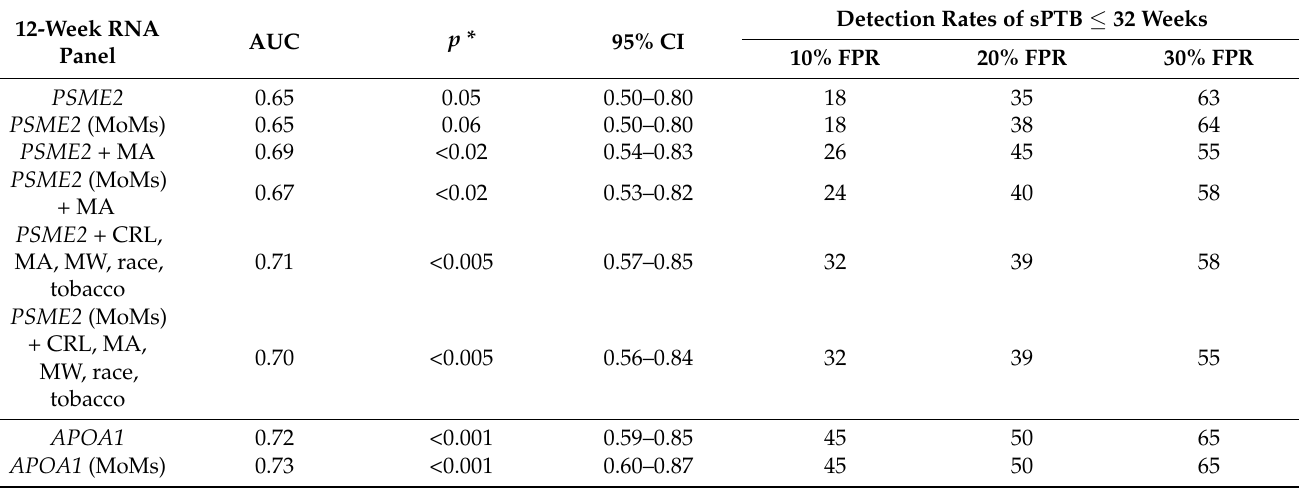
Table 1. Performance of the Differentially Expressed RNAs in First Trimester